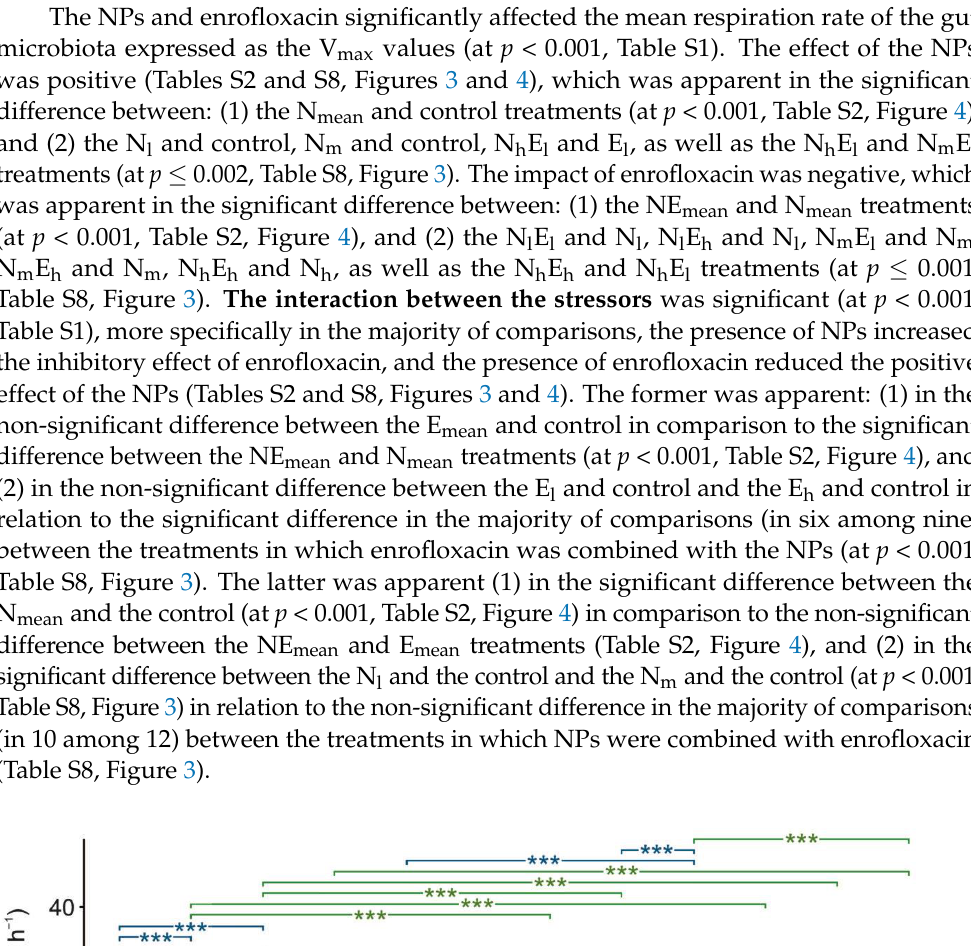
Figure 4. Mean values (± 1 SE) of respiration rate expressed as V max values of 31 carbon sources by Daphnia gut microbiota from the control variant (Cont.) and from variants of a single or combined mean density of polystyrene NPs (N mean for the combined data from N l = 10 3 , Nm = 10 6 , and N h = 10 9 particles L − 1 ) and the mean concentration of enrofloxacin (E mean for the combined data from E l = 10 and E h = 100 ng L − 1 ). Statistical significance is accepted at *** p < 0.0005, ns stands for non- significant. The NPs effect is marked on blue, and the enrofloxacin effect on green. The analysis of the percentage share of the respiration rate of different carbon sources by the gut microbiota of Daphnia revealed that the presence of each of the stressors resulted in a relative increase in the usage of carboxylic acids, amino acids, and carbohydrates, as well as a relative decrease in the usage of phosphorylated carbons and complex carbon sources with the control (Figure 5a,b). The pattern was similar in the presence of single and combined stressors, which suggests a negative interaction between their effects.